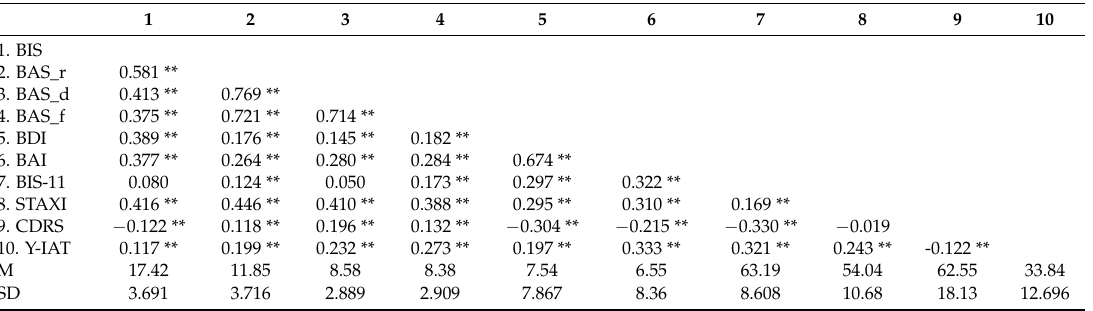
Table 1. Mean, standard deviation, and correlation of overall variables.